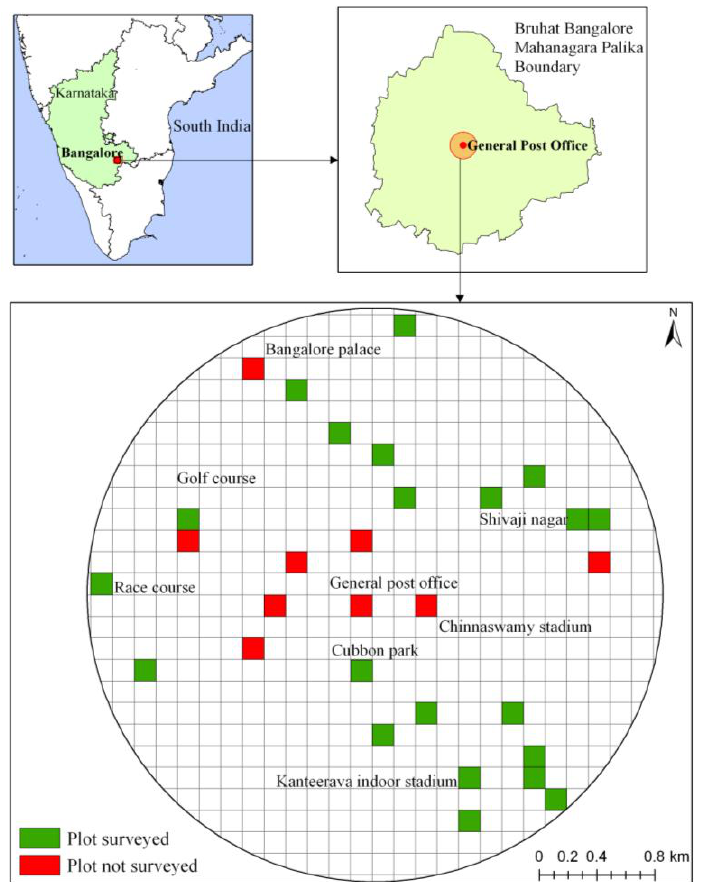
Figure 1. Map of Bangalore, depicting a 2 km circle in the center where grid cells were overlaid for sampling, with local place areas within the city also marked for